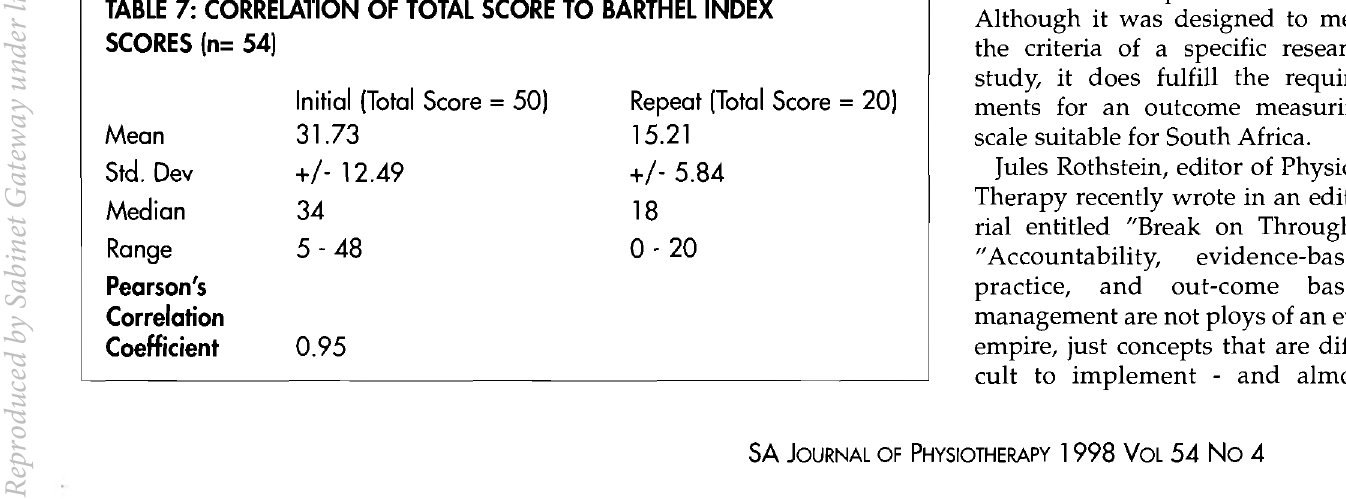
TABLE 7: CORRELATION OF TOTAL SCORE TO BARTHEL INDEX SCORES (n= 54) Initial (Total Score =